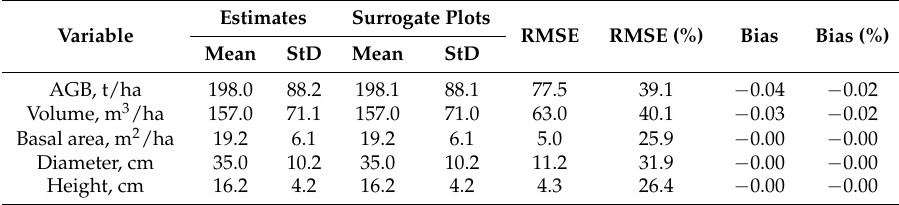
Table 10. Error statistics for the LAMP3 estimates after histogram matching, when compared to LiDAR predictions, on 9805 surrogate plots of 1-hectare size